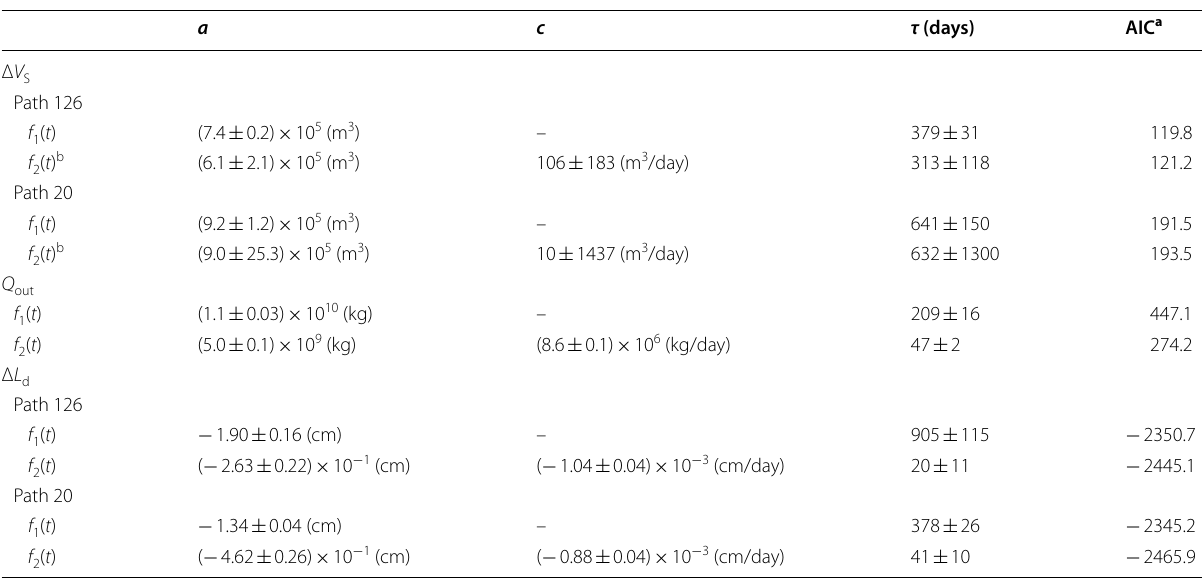
Table 1 Best-fit parameters of time